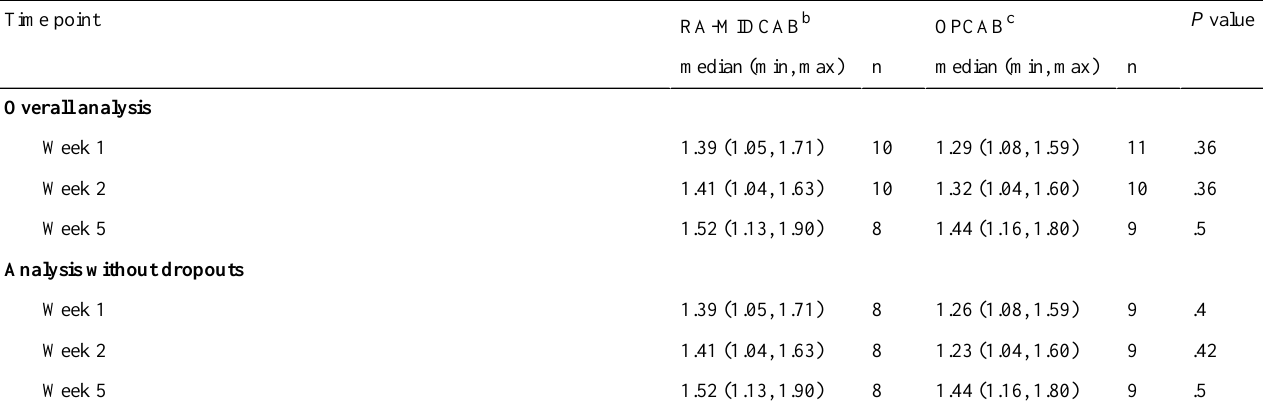
Table 3. Physical activity level a analysis recorded by Fitbit Charge HR in RA-MIDCAB and OPCAB